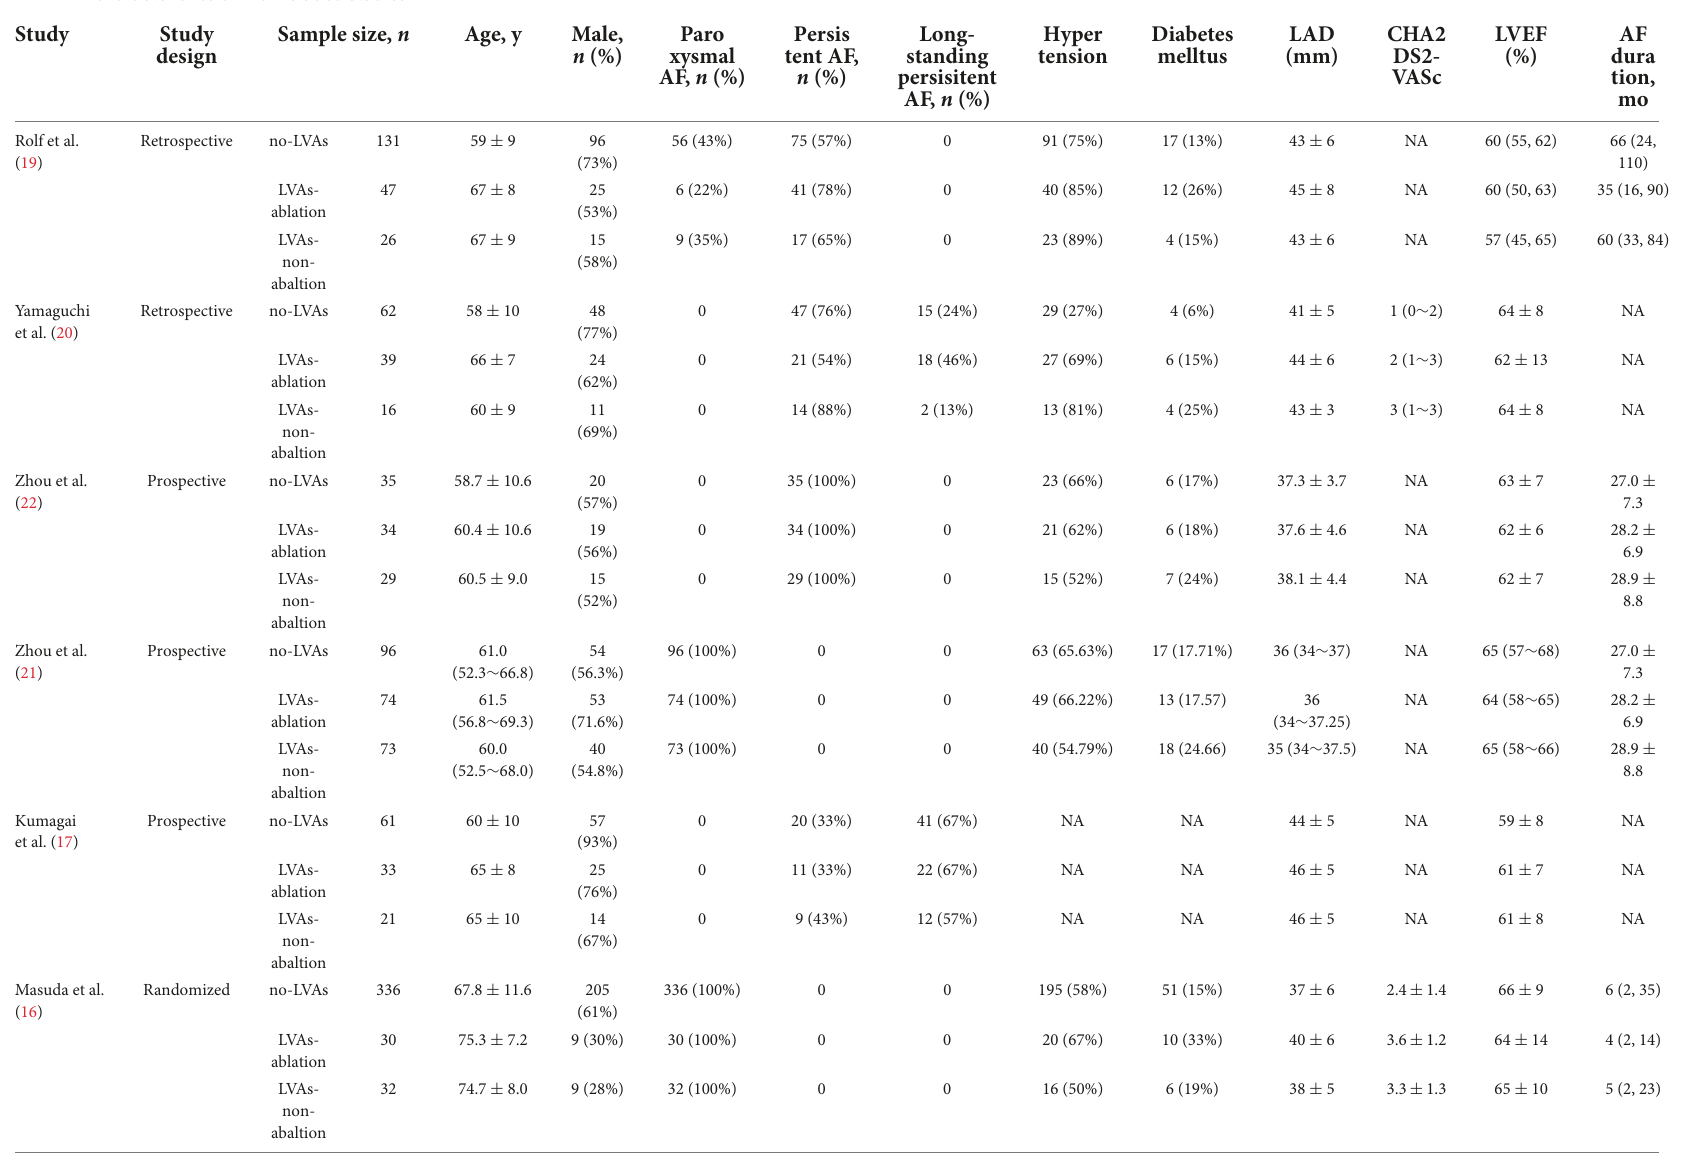
TABLE 1 Characteristics of the included